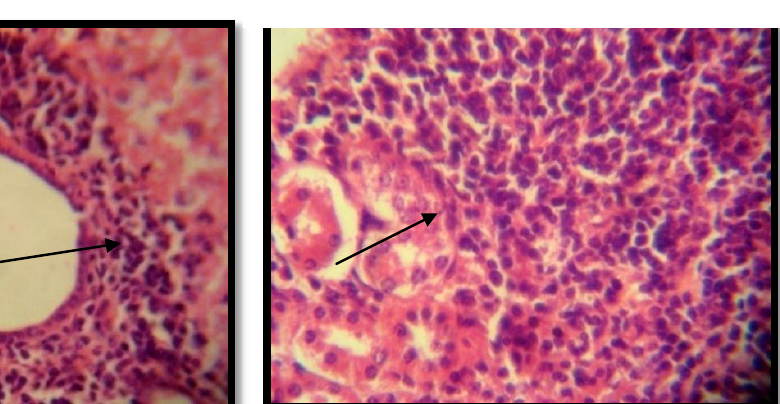
Figure 6: Liver of mouse treated with 16mg/kgbw of pentoxifylline for2month showing infiltration of mononuclear cells within parenchyma( ) (H&EX40)